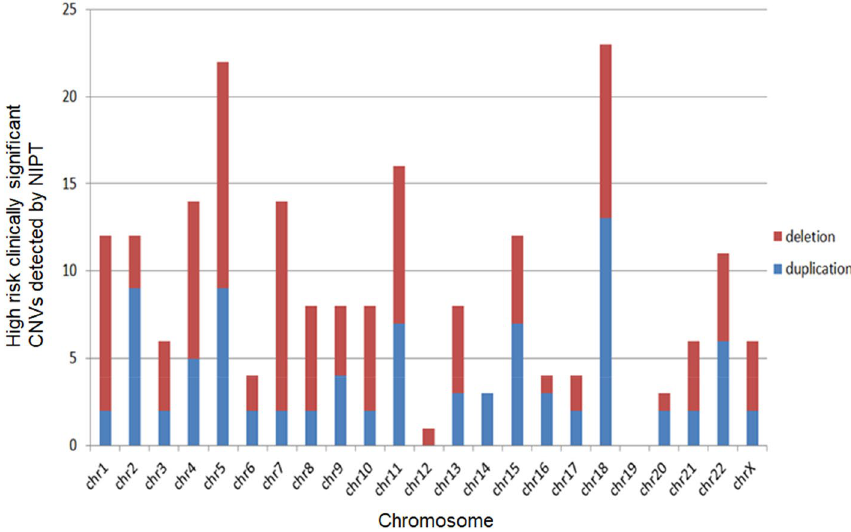
Figure 2. Autosomal and sexual CNVs detected by NIPT in 221 cases were distributed on each autosome and sexual except chromosome 19, and CNVs on chromosomes 4, 5, 7, 11, 15 and 18 were the most common. CNV copy number variation, NIPT noninvasive prenatal testing, chr